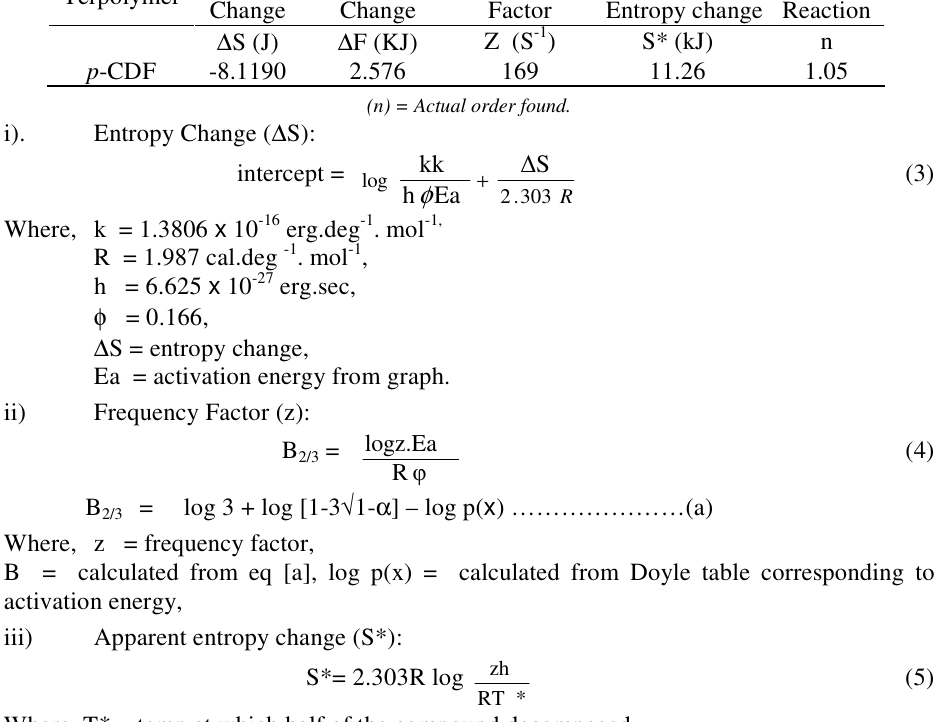
Table 4. Kinetic parameters of p -CDF terpolymer resin Entropy Free Energy Frequency Apparent Order of Terpolymer Change Change Factor Entropy change Reaction -8.1190 2.576 169 11.26